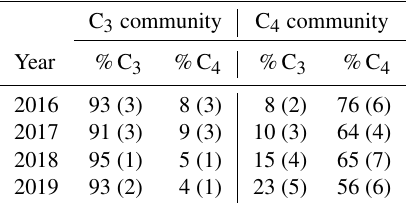
Table 1. Relative contribution to total aboveground biomass from C 3 sedges ( Schoenoplectus americanus ) and C 4 grasses ( Spartina patens and Distichlis spicata ) in each plant community. Values are means and SE ( n =